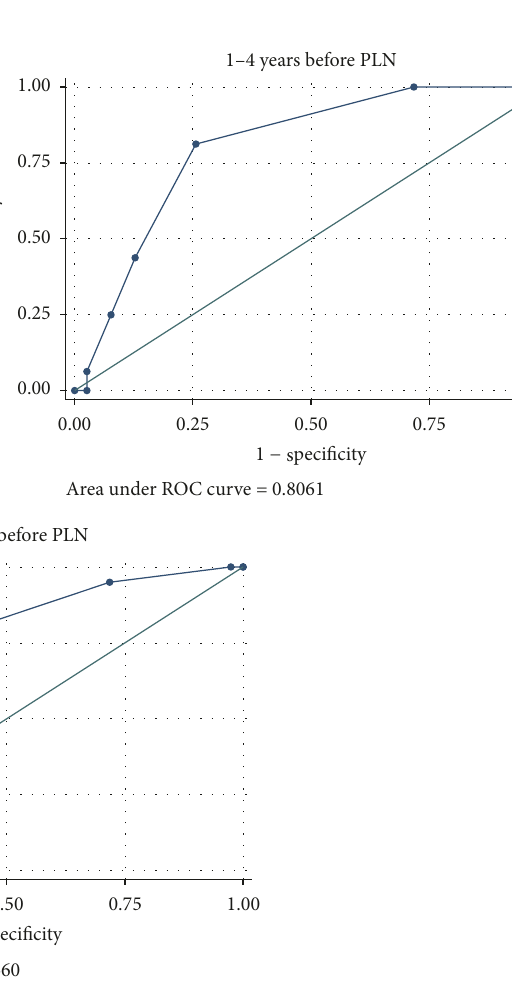
Figure 1: MPO-ANCA receiver operating curves for PLN cases versus healthy controls for < 1 year, 1–4 years, and > 4 years before PLN